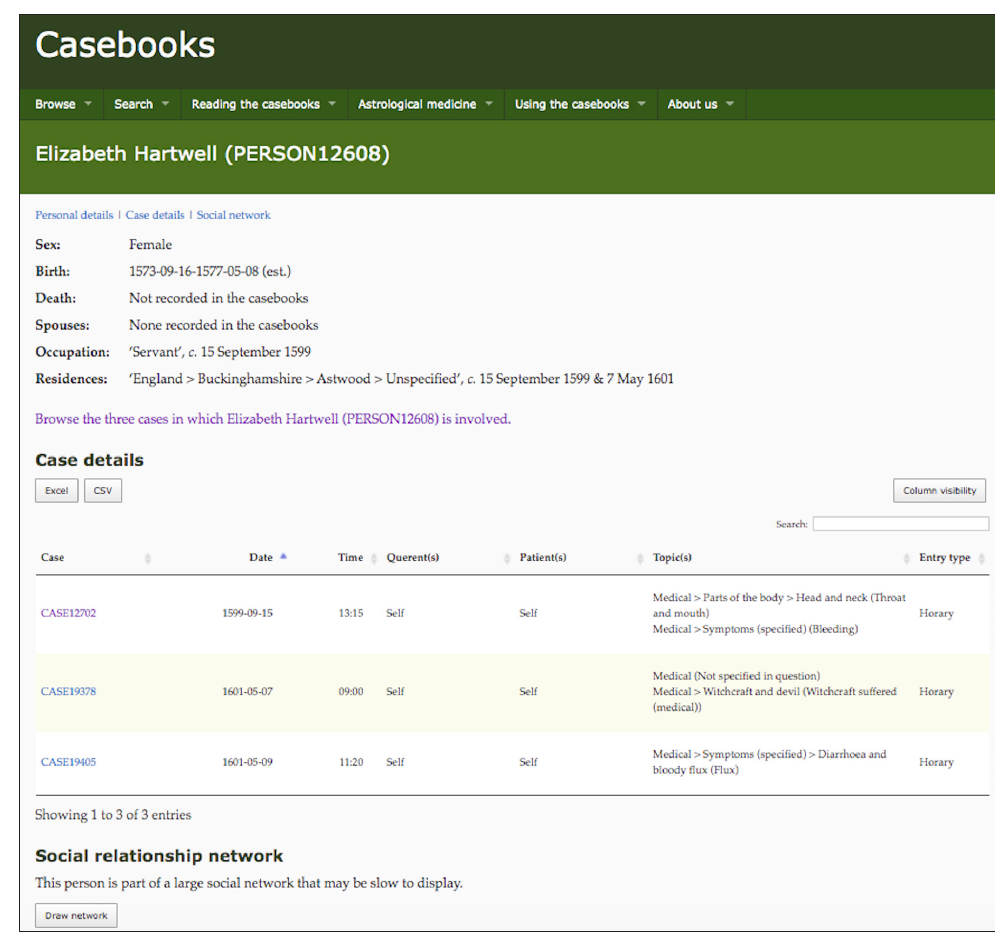
Figure 7: Elizabeth Hartwell’s person page. Lauren Kassell, Michael Hawkins, Robert Ralley, John Young,